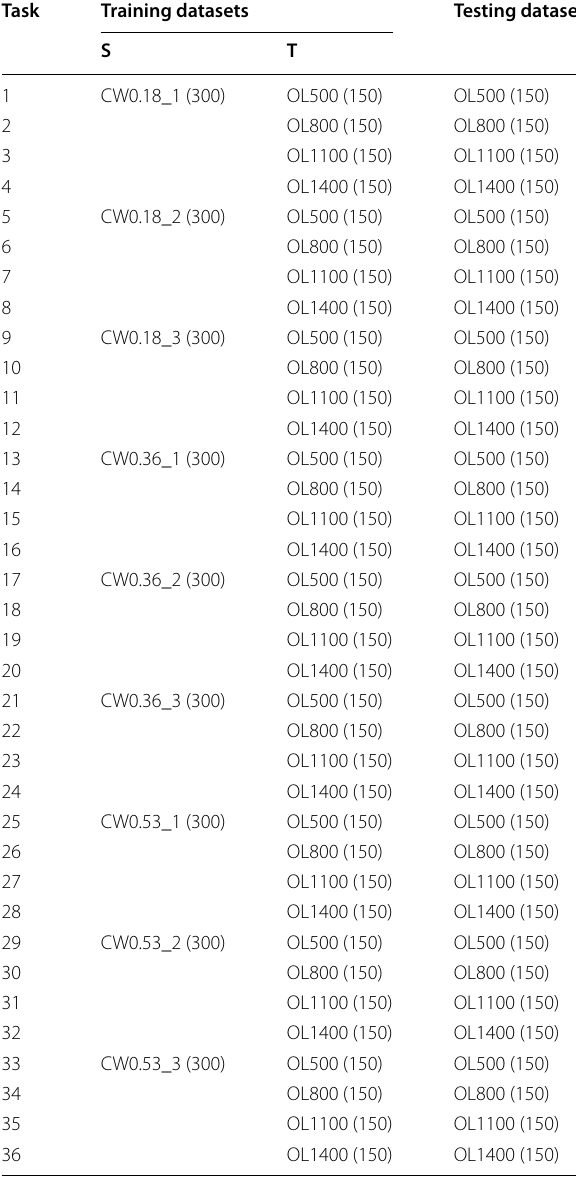
Table 3 Cross equipment tasks